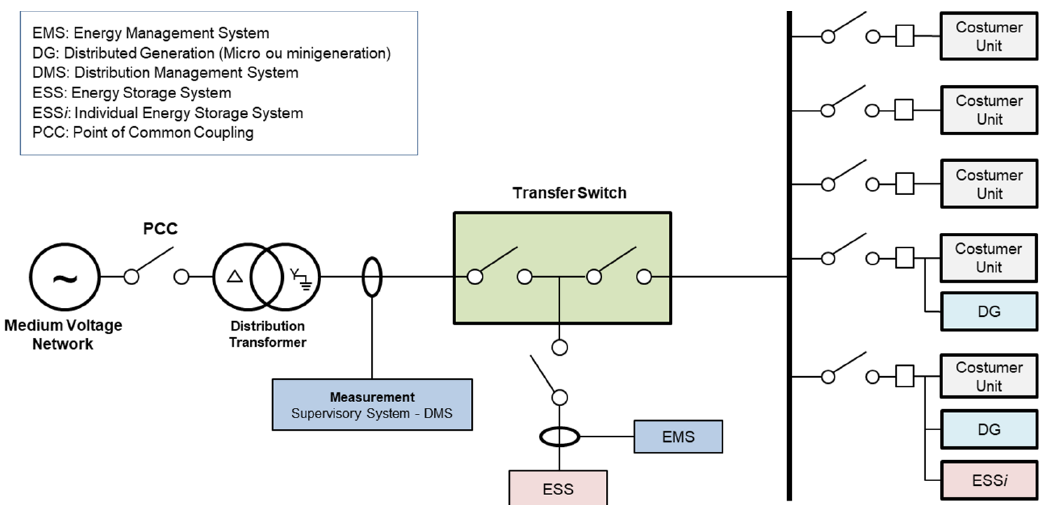
Figure 5. Point of connection diagram of condominium microgrid installation with central ESS connected to the secondary distribution network.